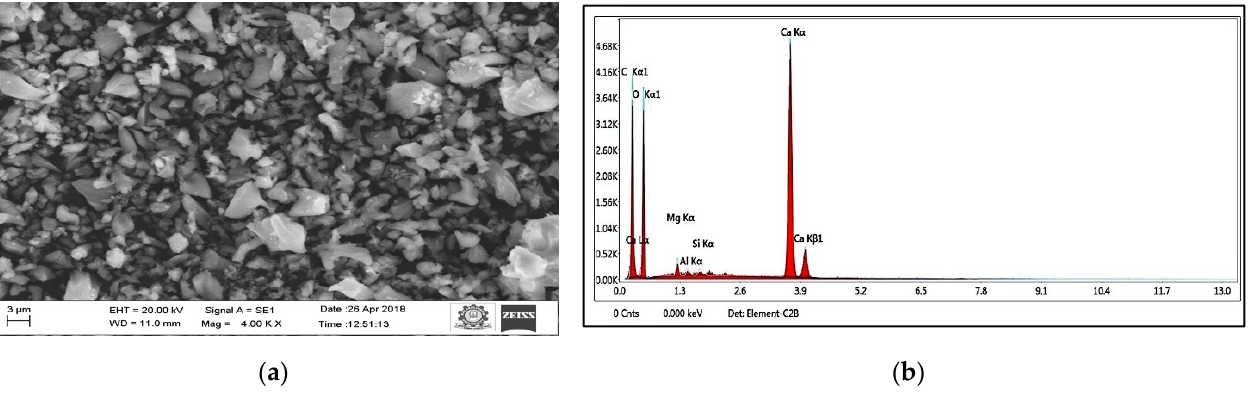
Figure 4. ( a ) SEM image of Lime powder; ( b ) EDAX image of Lime powder.